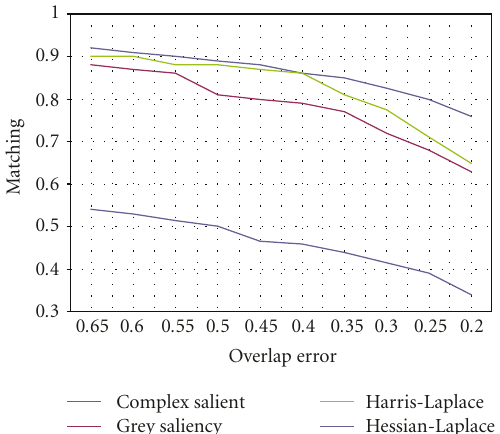
Figure 13: Matching percentage of the region detectors for the set of 30 car samples of di ff erent points of views in terms of regions intersection percentage.